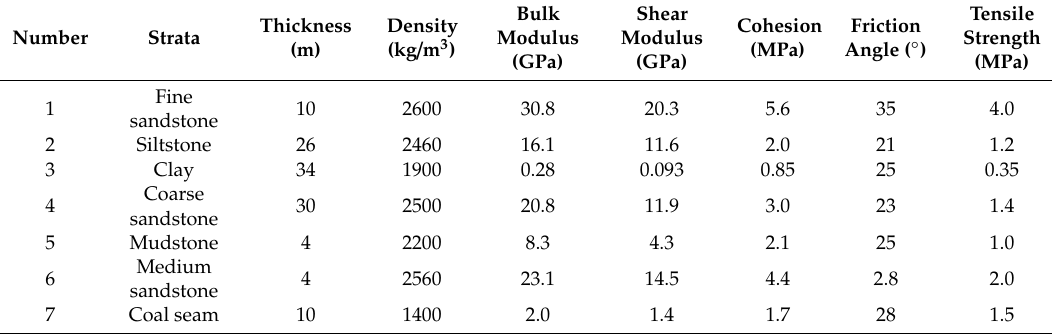
Figure 12. Numerical simulation model of sand-soil-bedrock stratigraphic structure. Table 3. Rock physical and mechanical parameters (block).